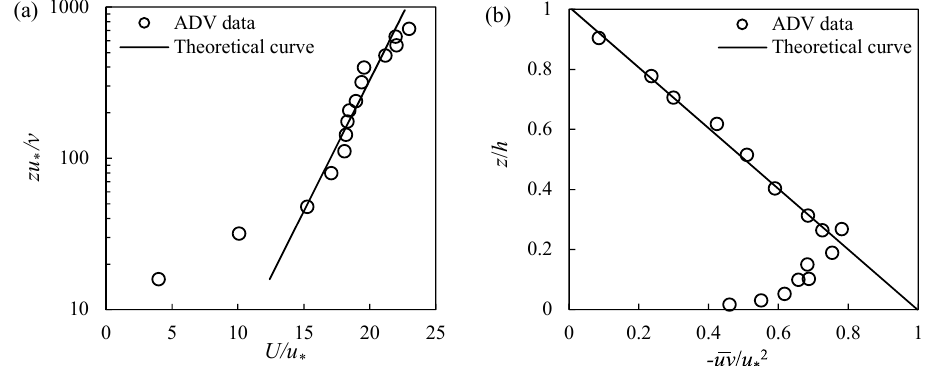
Figure 4. Profiles of ( a ) mean streamwise velocity and ( b ) turbulent stress in the upstream far away from the pile group.